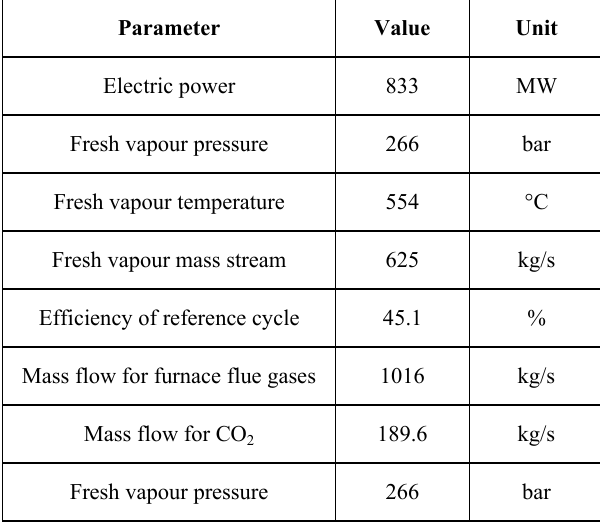
Table 1. Basic parameters of the reference power cycle [22].